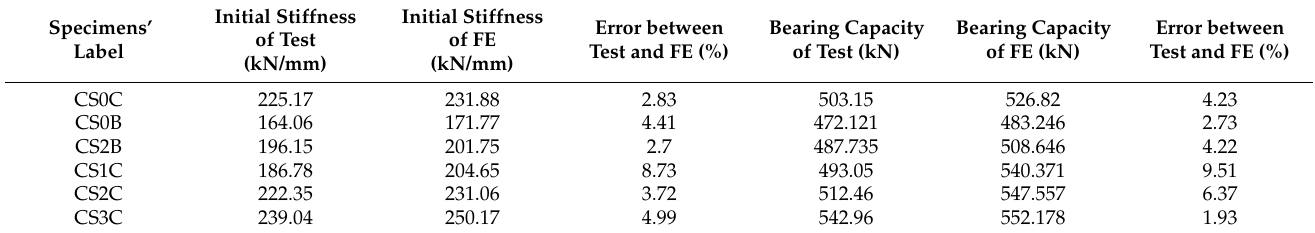
Figure 9. Comparisons between simulated results and tested results of V - ∆ curves of some specimens. Table 3. The error of between test and finite element.